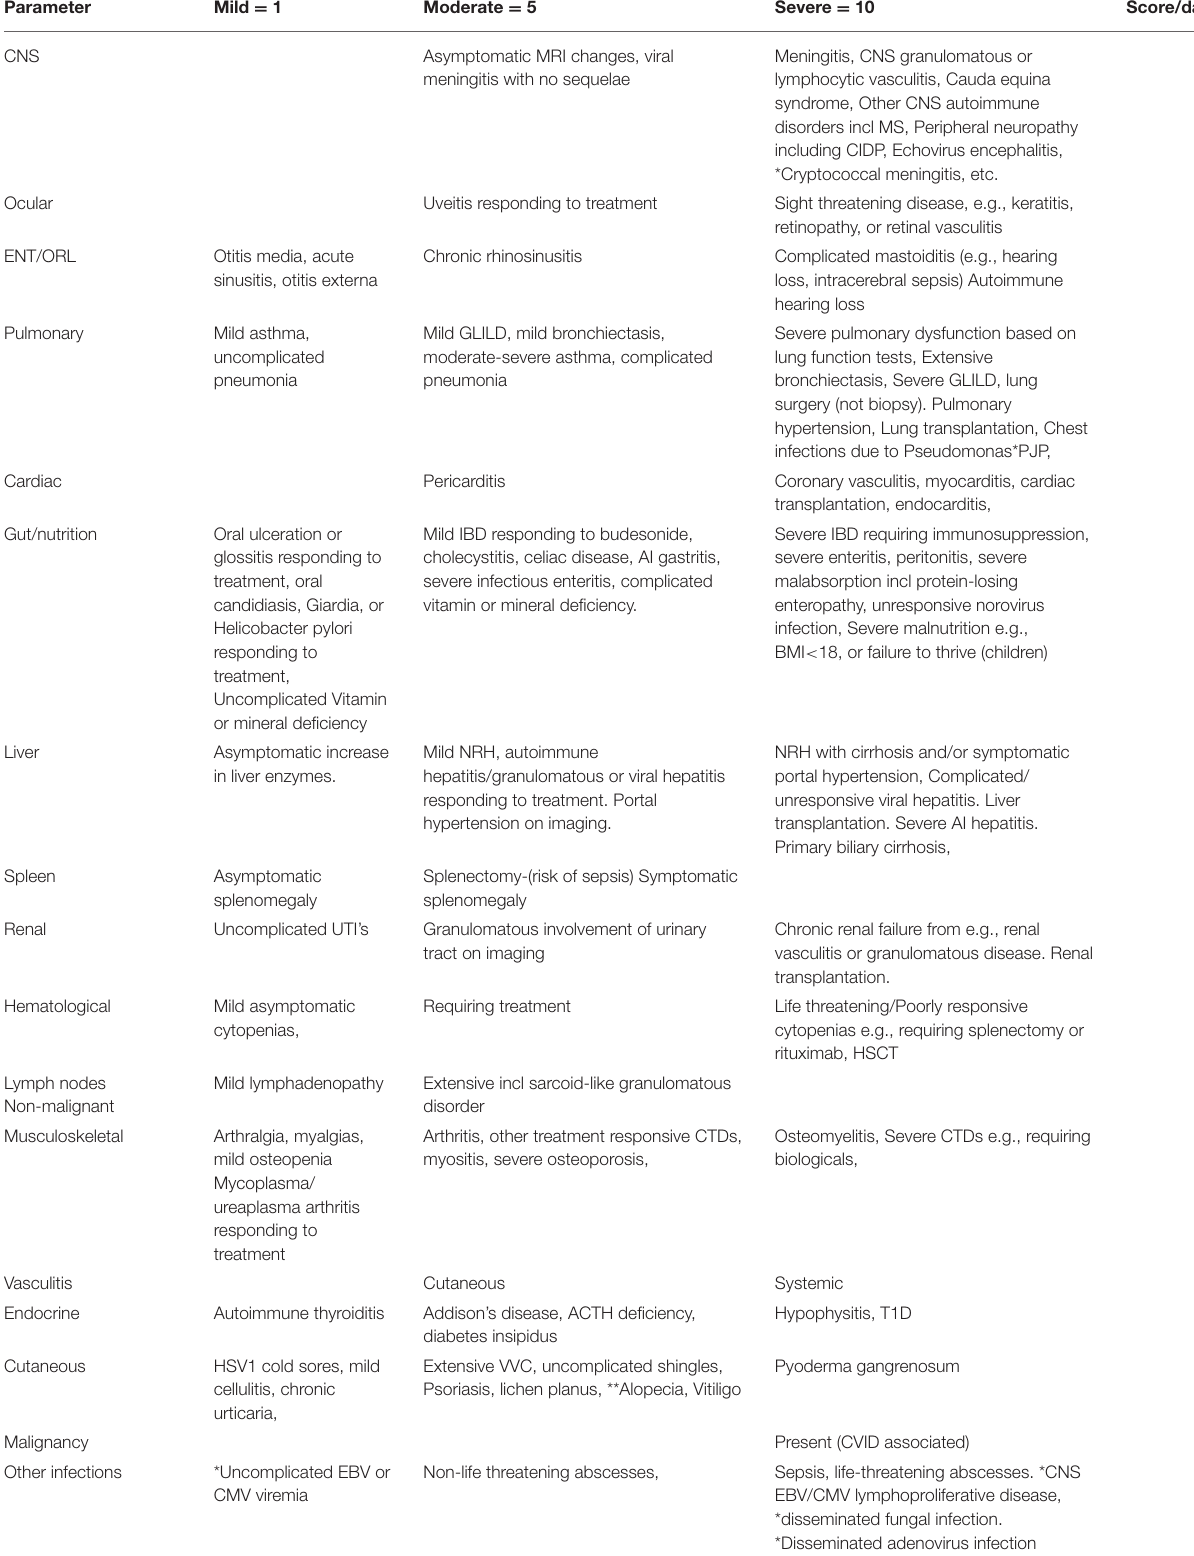
TABLE 1 | An instrument for assessing CVID disease severity.